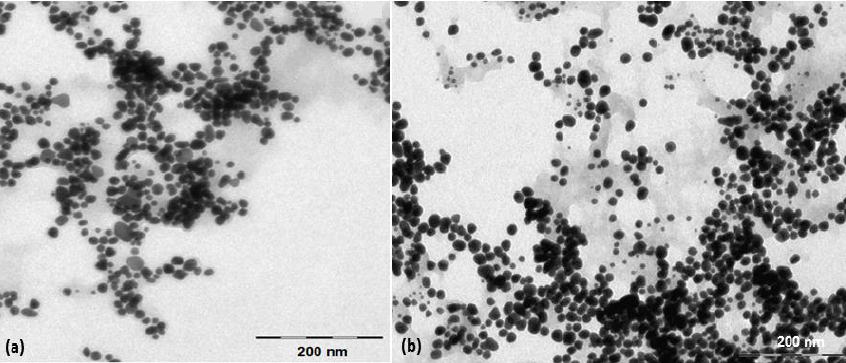
Figure 2. TEM (transmission electron microscopy) images of Ag-CM nanoparticles ( a ) and Au-CM nanoparticles ( b ) biosynthesized with Cornus mas fruit extract as source of reducing and capping agents. Zeta potential, measured by laser Doppler microelectrophoresis, was −31 mV for Ag-CM and −24.4 mV for Au-CM (Figure 3).